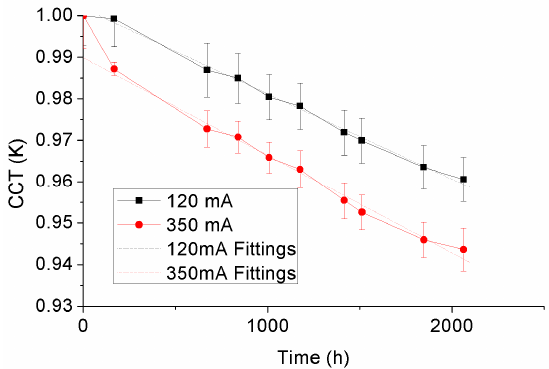
Figure 16. CCT depreciation of the 4000 °K samples.